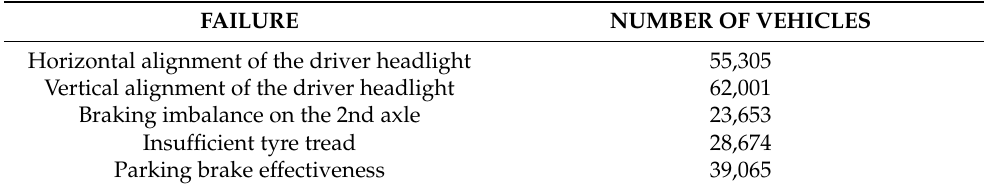
Figure 6. VTI representative failures for subcategory N1. Figure 7 shows the results for the subcategory M3 bus type. For this subcategory, the most representative failures are suspension effectiveness on the right wheel of the 1st axle, suspension effectiveness on the right wheel of the 2nd axle, suspension effectiveness on the left wheel of the 1st axle, suspension effectiveness on the left wheel of the 2nd axle, each one with a percentage of around 10.5%. Braking effectiveness (7.7%), vertical align- ment of the driver headlight (6.5%), horizontal alignment of the driver headlight (4.9%),